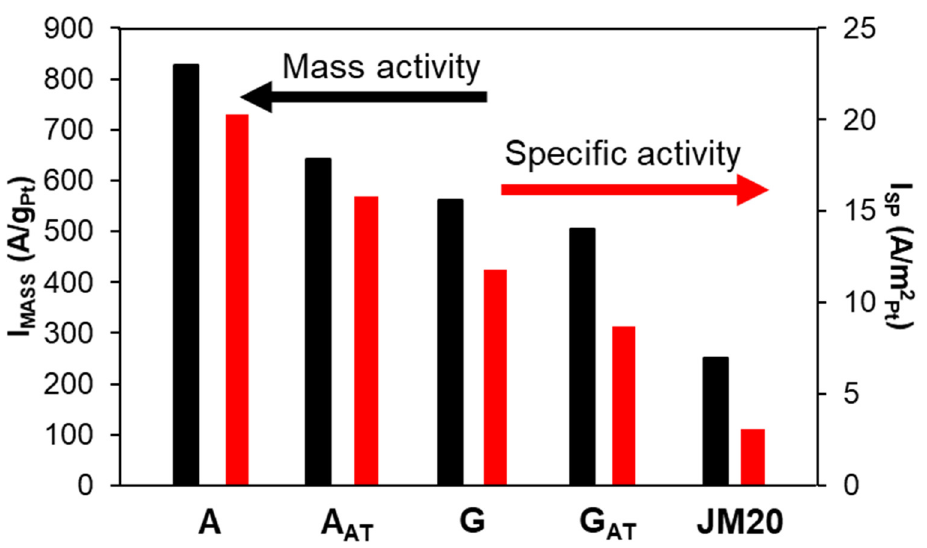
Figure 5. The histograms of mass and specific activities for the obtained PtCu/C catalysts and the commercial Pt/C analogue. commercial Pt/C